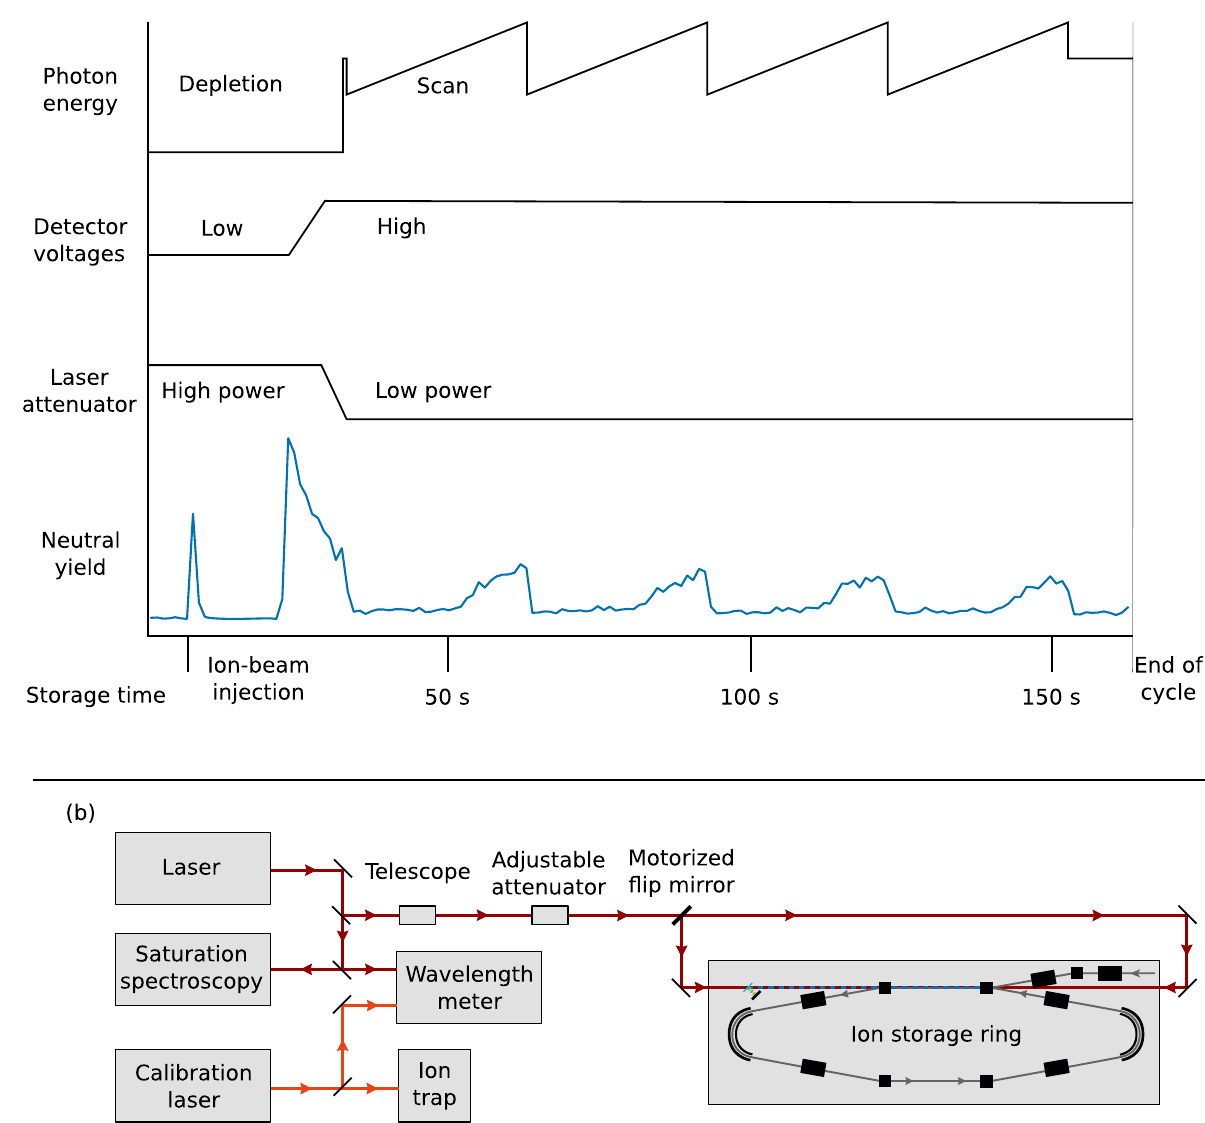
Fig. 6 | Timing and optical scheme of the measurement procedure. In a the timing of the laser, attenuator, and detector is shown together with a real-time example of the neutral yield on the detector. Note that there is still a signal even thoughthedetectorisinalowoperationmode forthe fi rst~30s.Thisisduetothe highnumberofneutralsgeneratedbythedepletionoftheionsintheexcitedstate.